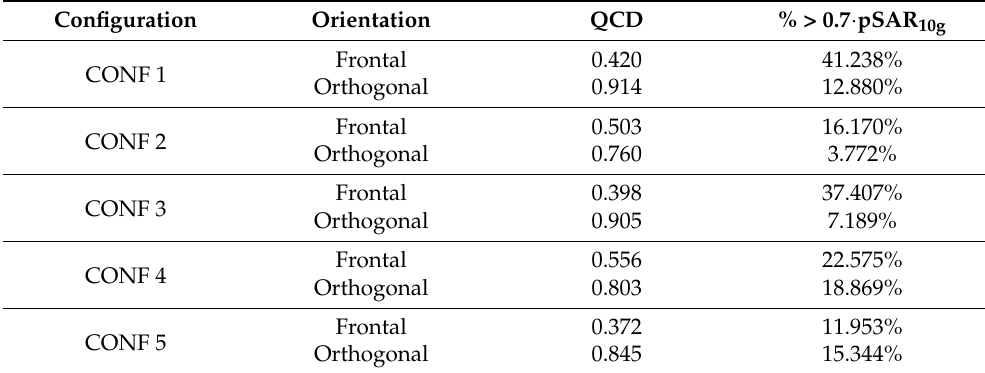
Table 4. QCD and percentage of values higher than 0.7 pSAR 10g of each configuration for the eye tissues 1